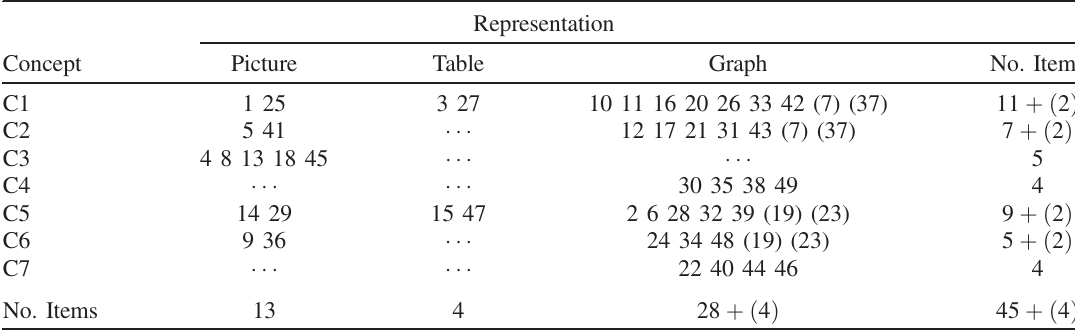
TABLE III. Categorization of the 49 items. Each item (except the four in parentheses) can be assigned to a single concept and a single representation. Representation Concept Picture Table Graph No.